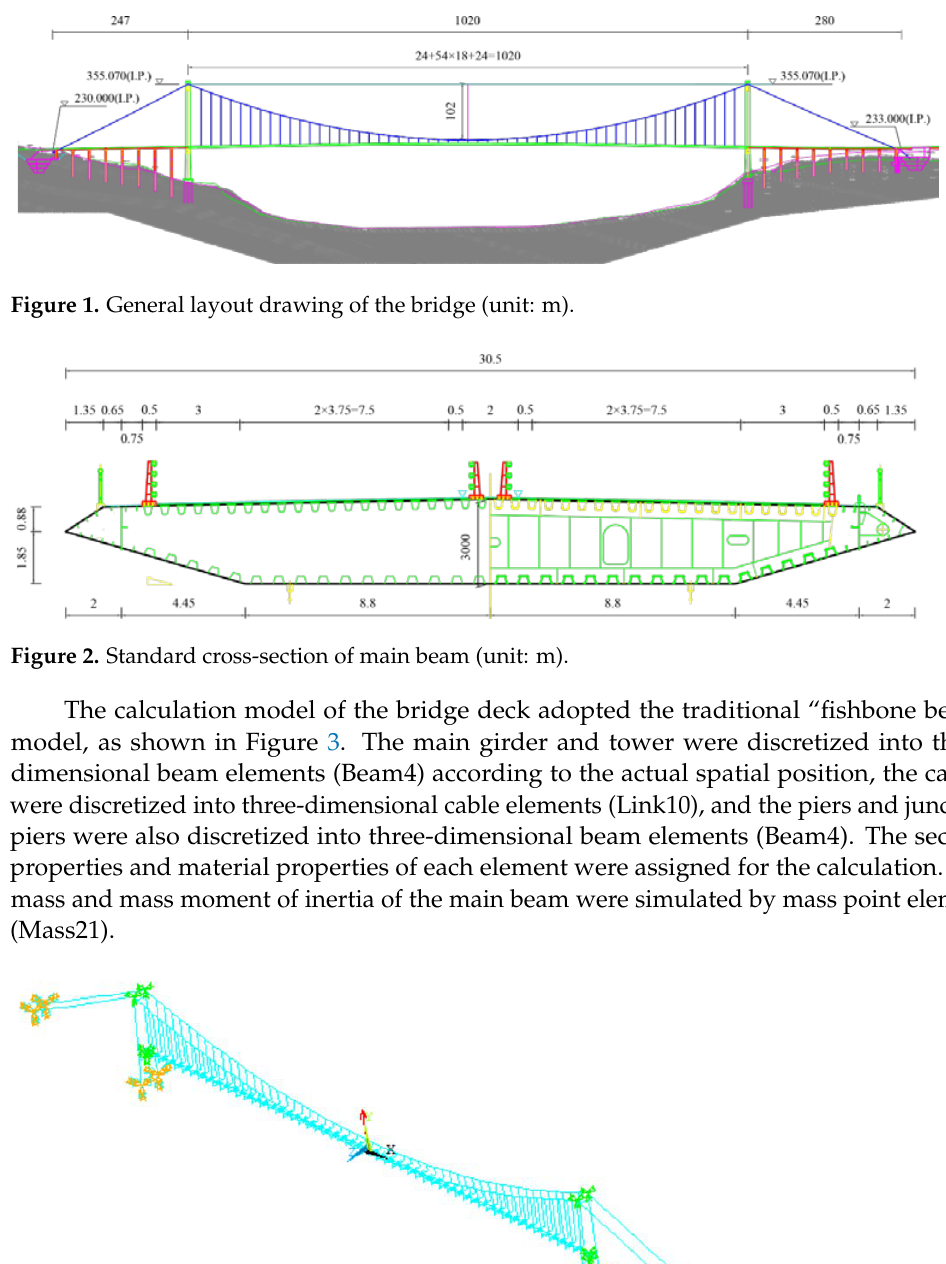
Figure 1. General layout drawing of the bridge (unit: m).